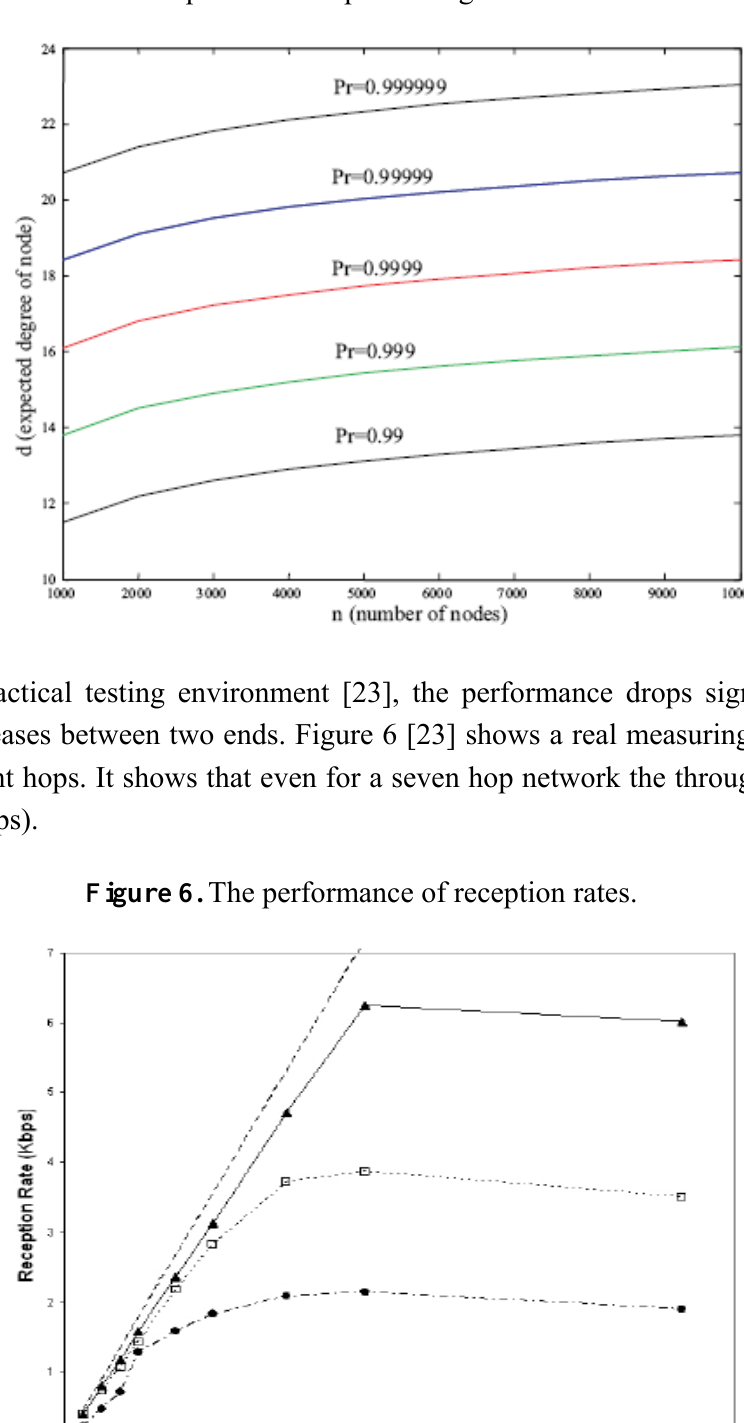
Figure 5. The relationship between expected degree of node and number of nodes.